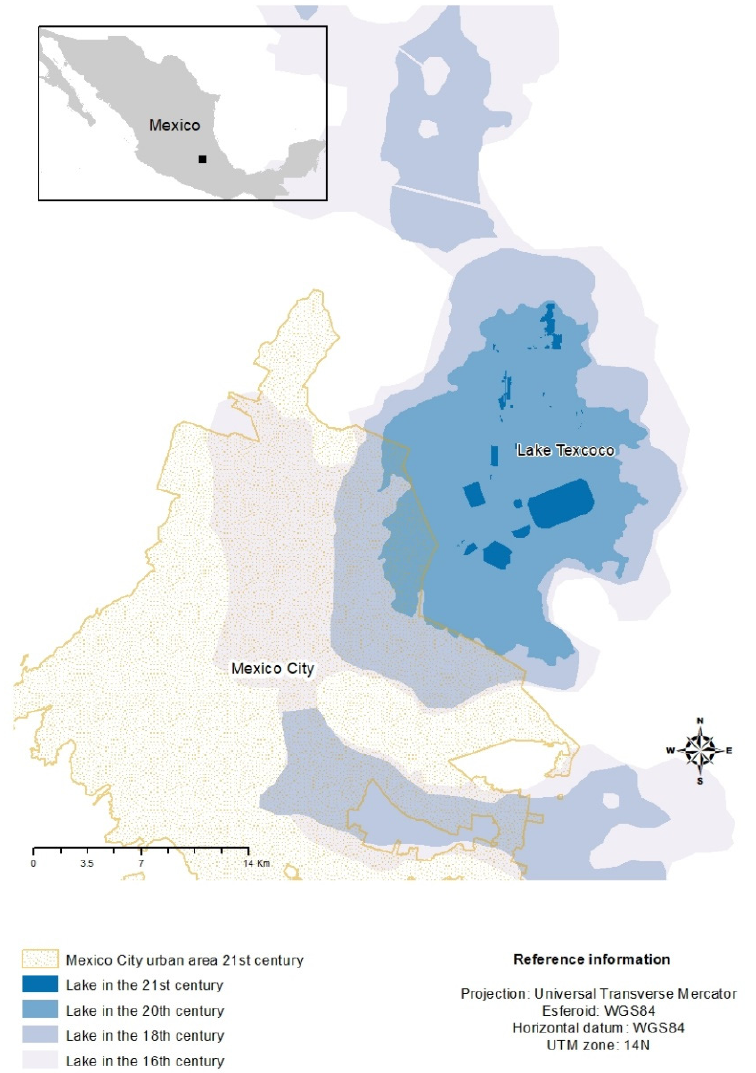
Figure 3. Historical evolution of the desiccation of Lake Texcoco. Own elaboration based on data from CONABIO [42] and Stangl [43], historical maps recovered from Mapoteca Orozco y Berra [44], and photo interpretation of satellite images from